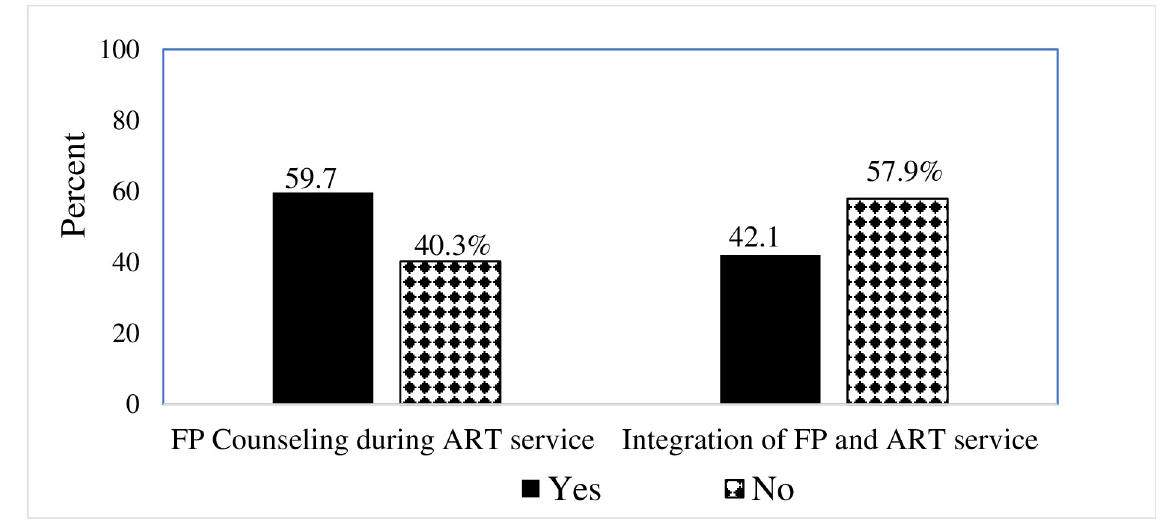
Fig 2. Health service-related factors among HIV-positive